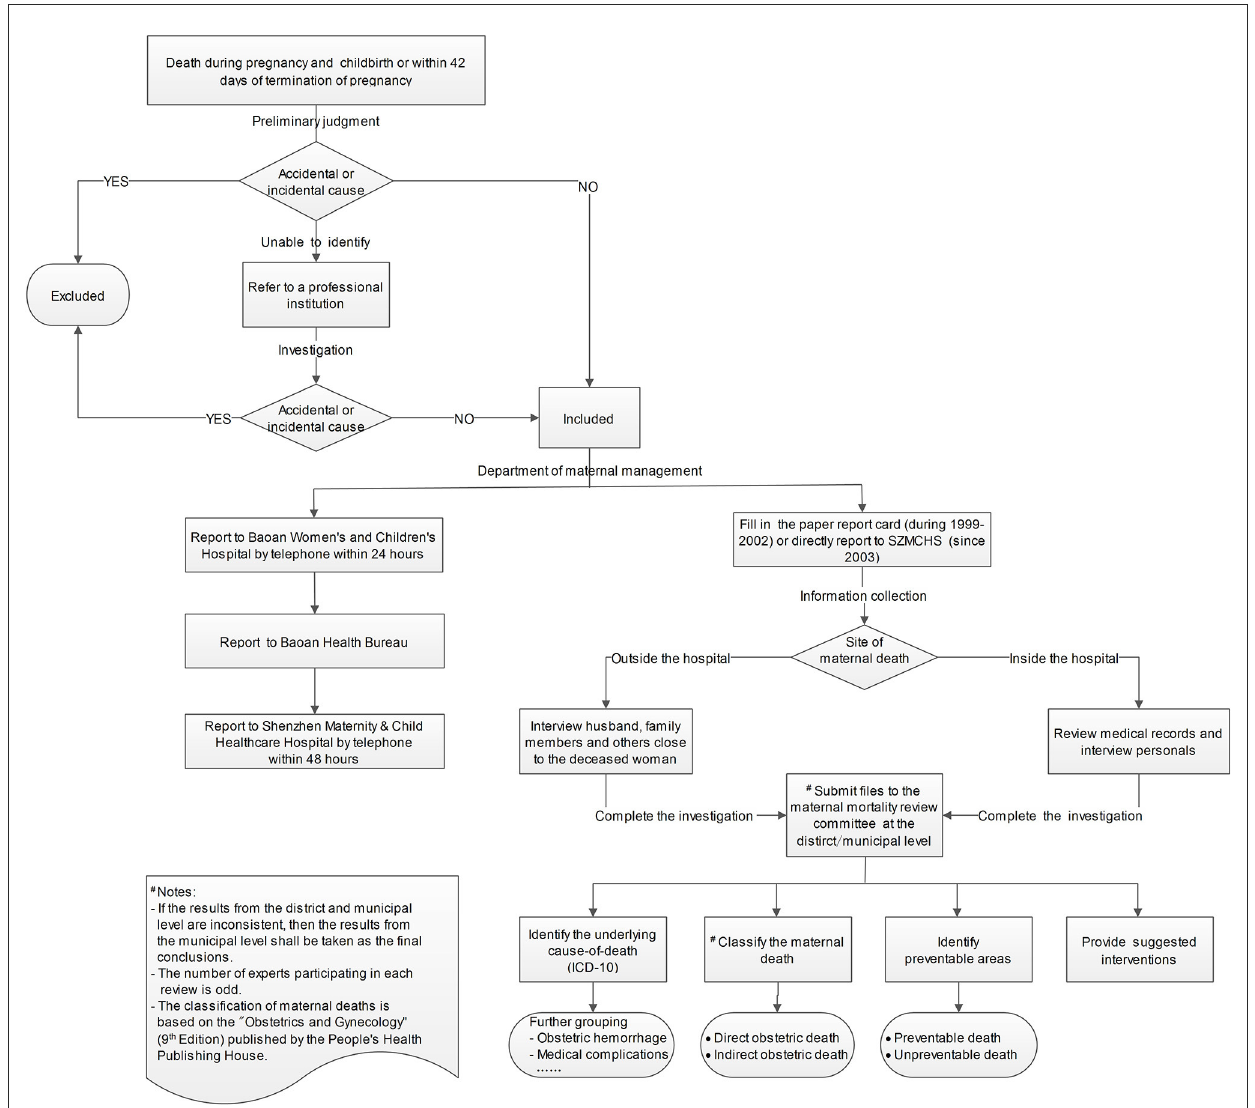
FIGURE1 The flow chart of maternal death report and determination of death cause in Baoan district.